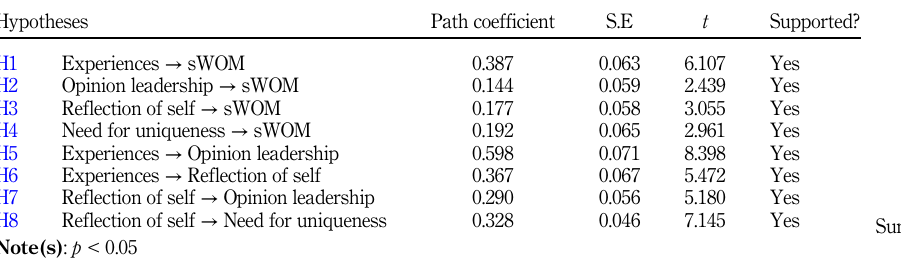
Table 3. Summary of